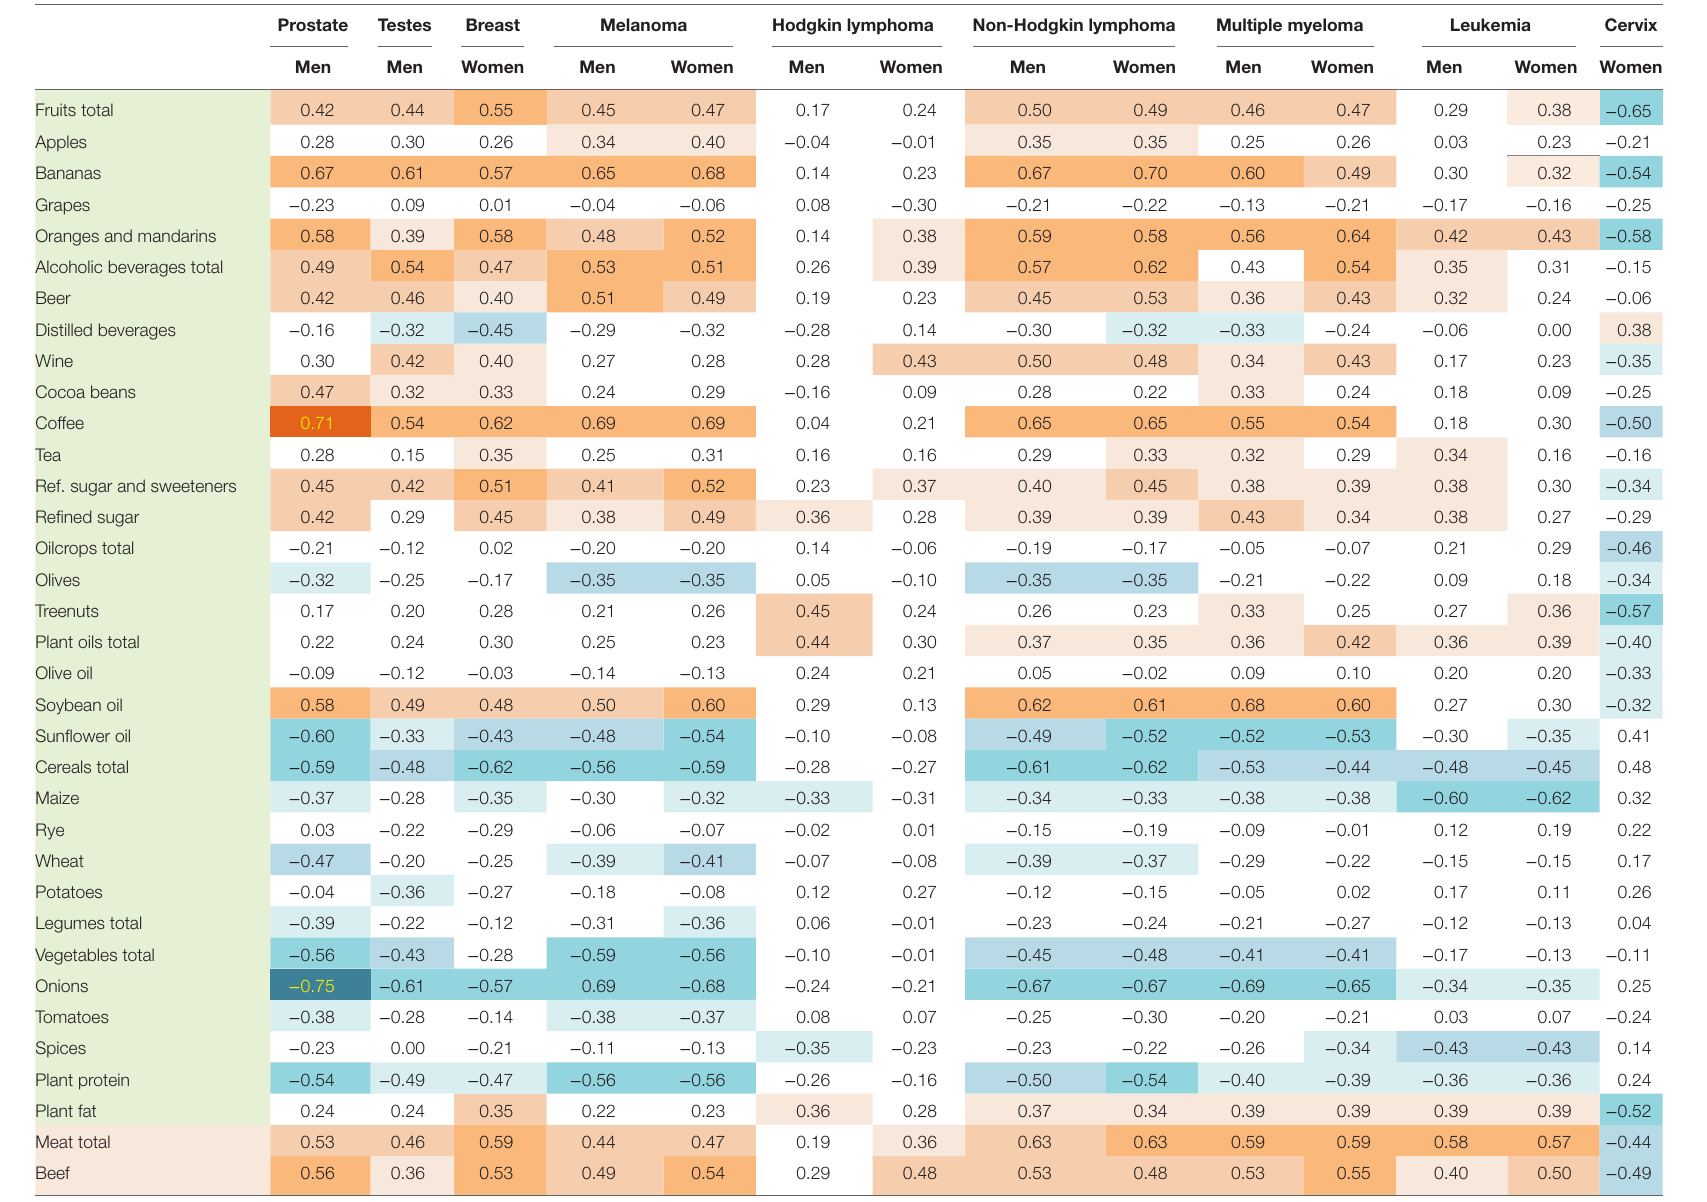
Table 1 | Correlations ( r -values) between nine types of cancer and variables examined in this study (for more detailed results, see Data Sheet S1 in Supplementary Material, Sheet 5).